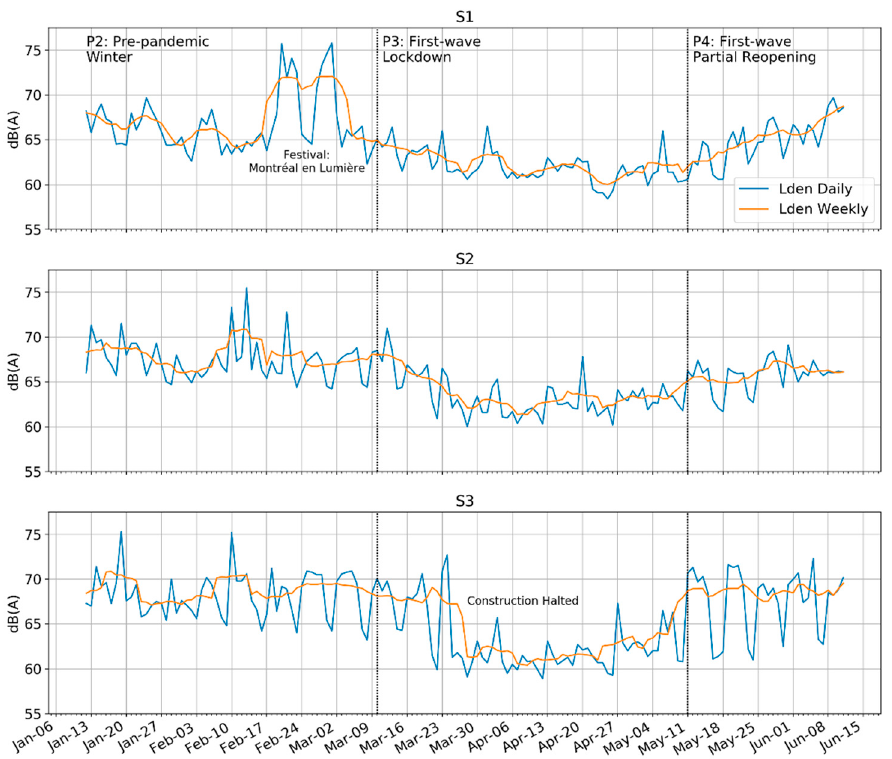
Figure 3. Daily L den and superimposed weekly rolling average L den across three sites in the Quartier des Spectacles (QDS). There is a clear ‘trough’ corresponding to the strictest measures associated with the Quebec/Montreal lockdown.